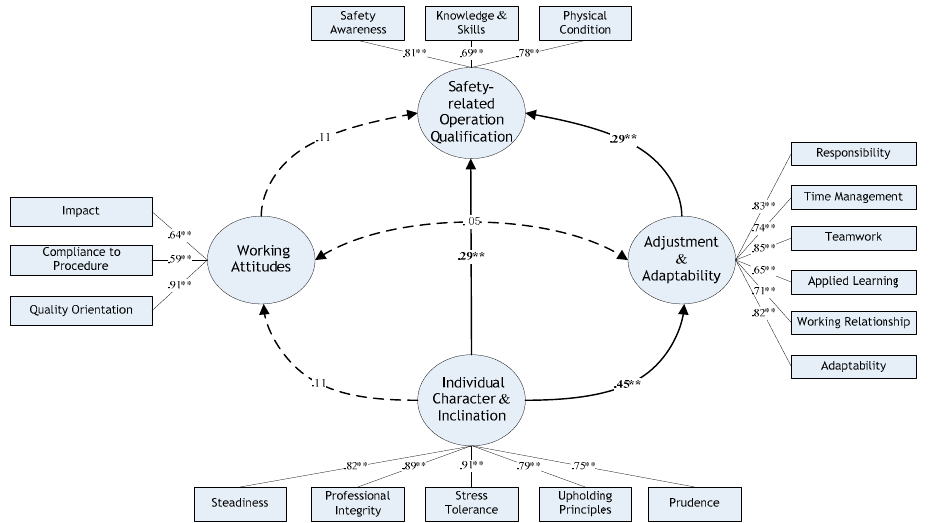
Figure 1. The Hierarchical Model of Construction Workers’ Safety competency. Asterisks accompanying the coefficients indicate the significance level for each path in the figure (i.e., two asterisks indicate p < 0.01 and one asterisk indicates p < 0.05).